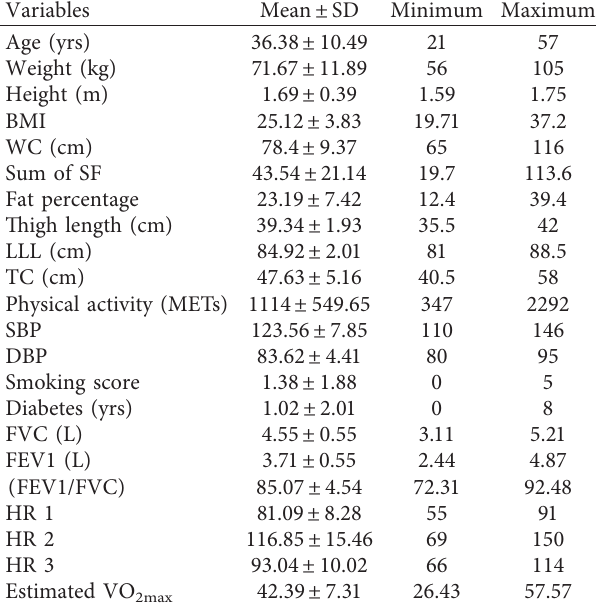
Table 1: Basic characteristics of participants.